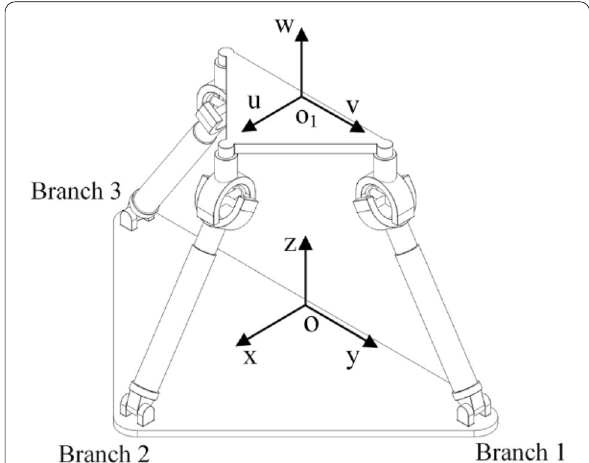
Figure 8 The schematic of the 3-RPU PM without parasitic